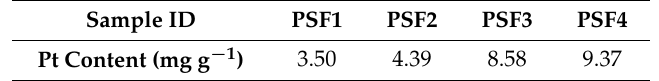
Table 1. Pt content of silk fabrics treated in the presence of different concentrations of H 2 PtCl 6 .